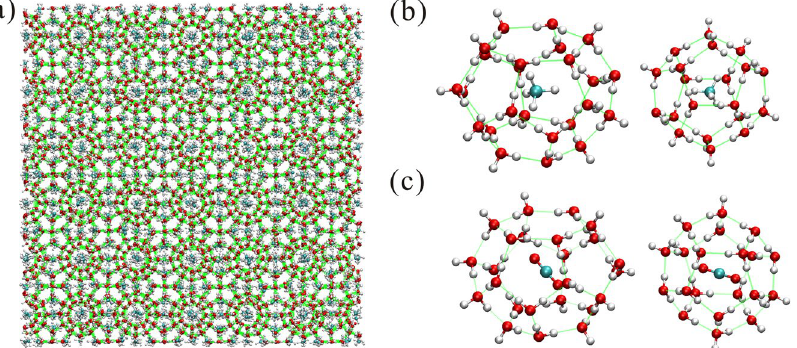
Figure 1. Gas hydrate (sI) microstructure. ( a ) Bulk structure of gas hydrate. ( b ) Large cage (5 12 6 2 ) and small cage (5 12 ) of CH 4 hydrate. ( c ) Large cage (5 12 6 2 ) and small cage (5 12 ) of CO 2 hydrate. Red, cyan, and white balls represent oxygen, carbon and hydrogen atoms respectively. Green lines represent hydrogen